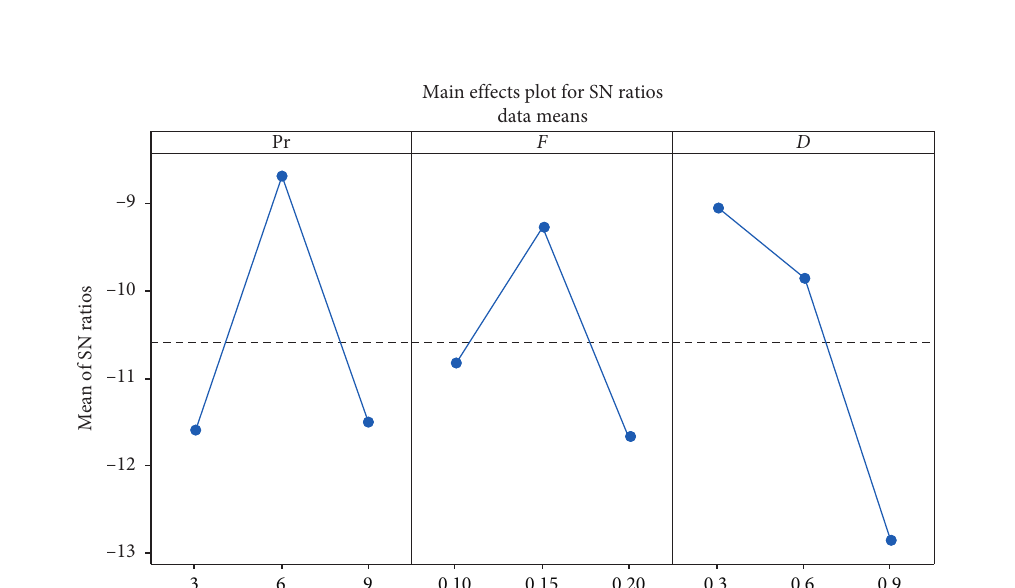
Figure 5: SN ratio-based important effect plot for the roughness on the machined surface; in the X -axis, Pr denotes pressure of cutting fluid (bar), F denotes feed (mm/rev), and D denotes depth of cut (mm).